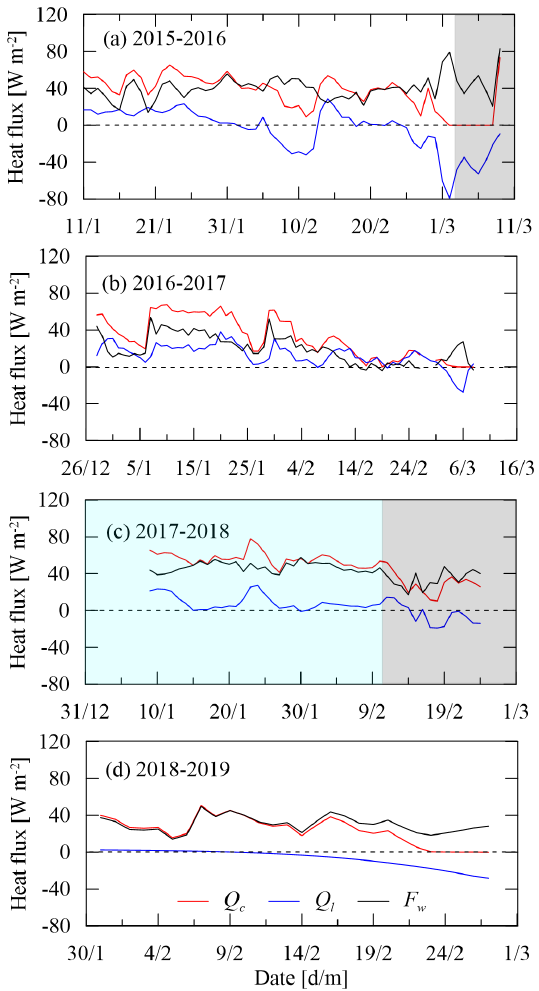
Figure 7. Heat fluxes at the ice–water interface ( Q c : conductive heat flux in the bottom ice; Q l : latent heat flux due to basal ice freezing/melting; F w : water-to-ice heat flux). The light gray and blue zones denote periods of convective mixing and stratification with the local “warm” layer (Fig. 5), respectively.